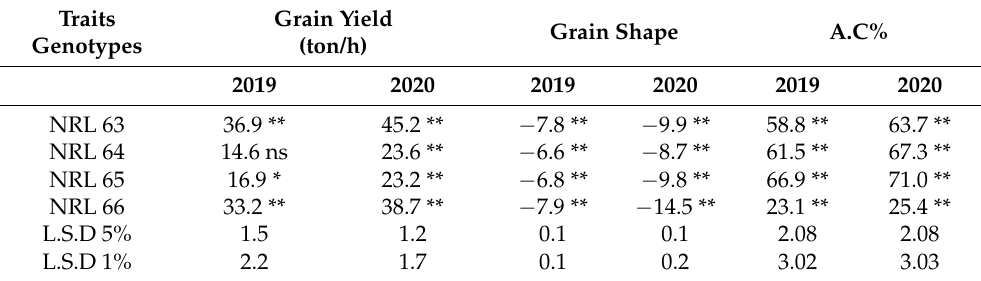
Table 12. Estimates of the percentage of advantage over commercial variety for the grain yield, grain shape (L/B ratio), and amylose content percentage of studied genotypes.